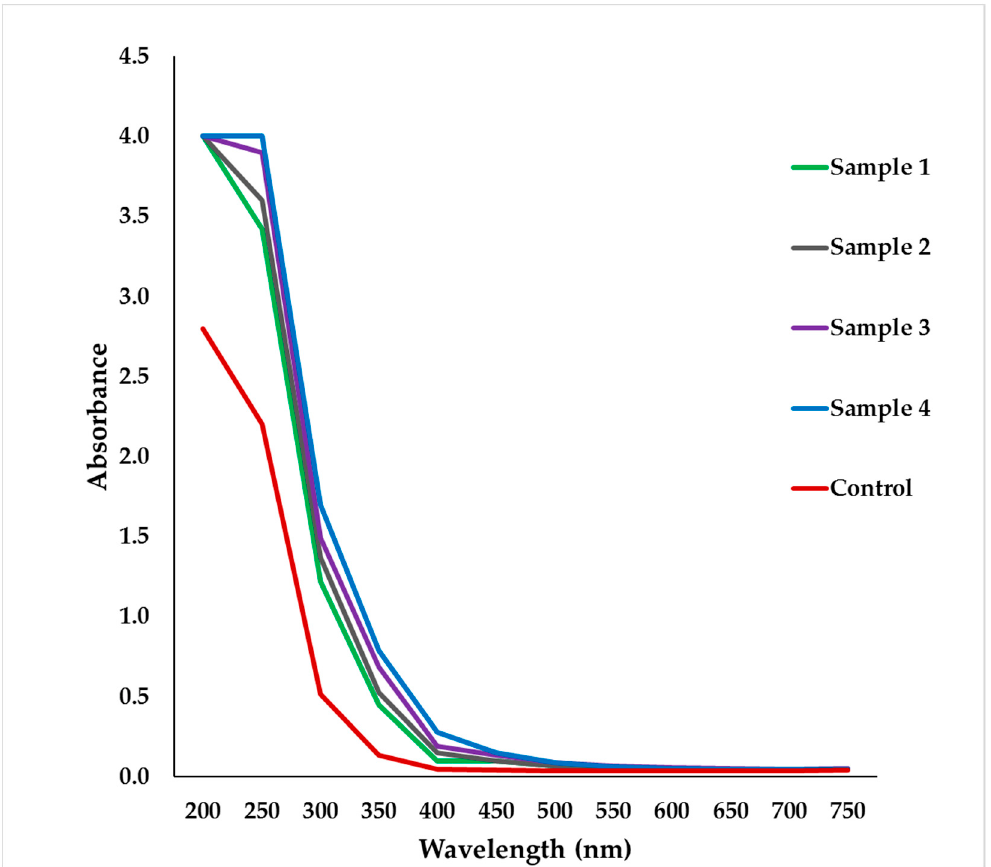
Figure 4. Microplate spectrophotometer absorption of nanoparticles of the garlic extract prepared using various sonication time and power (Sample 1, 2, 3, 4: sonicated samples, control: unsonicated